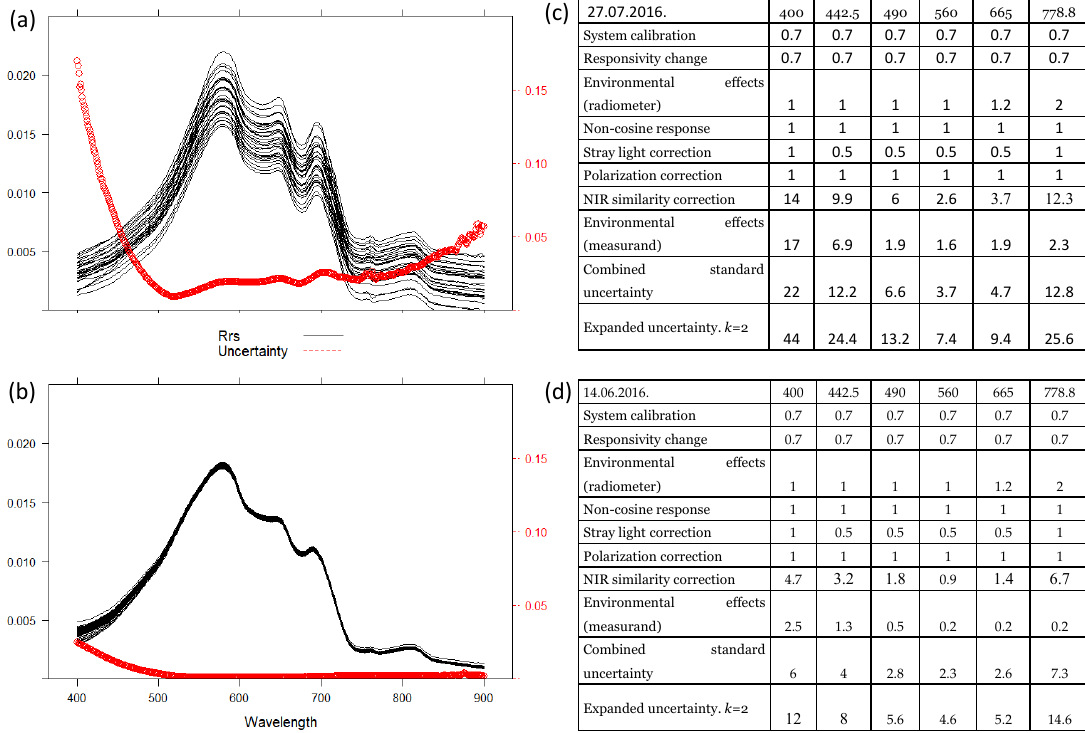
Figure 2. Example of radiometric data measured in two stations with di ff erent environmental conditions. Spectra measured during one station and derived uncertainty ( a , b ) and calculated uncertainty budget on selected bands ( c , d ). The upper row represents challenging conditions (ID 839 in Table A2) and panel ( b ) good conditions (ID 786 in Table